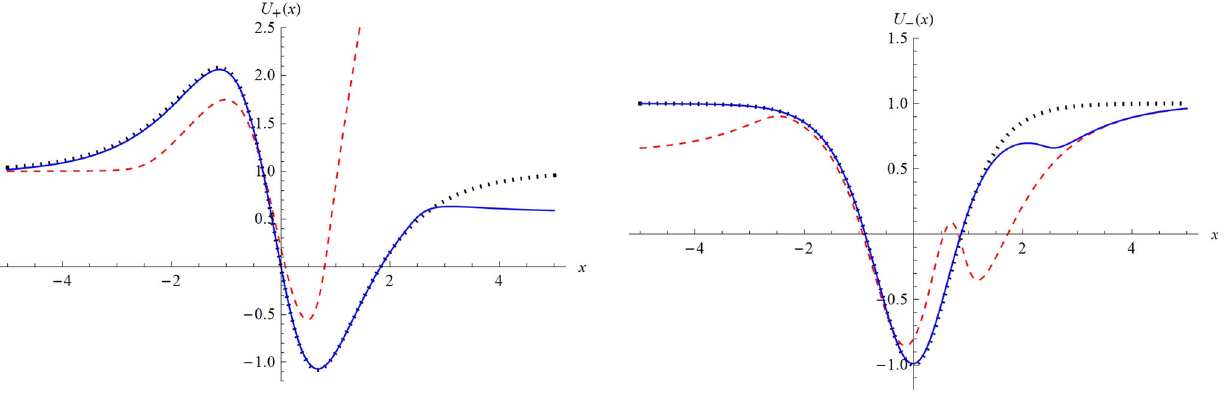
Fig. 9 Quantum-mechanical potentials U + (on the left) and U − (on the right) for b 3 = 0 and α = 1. For both, we have plotted the values a 2 = 0, a 2 = 0 . 01, and a 2 = 0 . 2, depicted with dotted, solid, and dashed lines, respectively